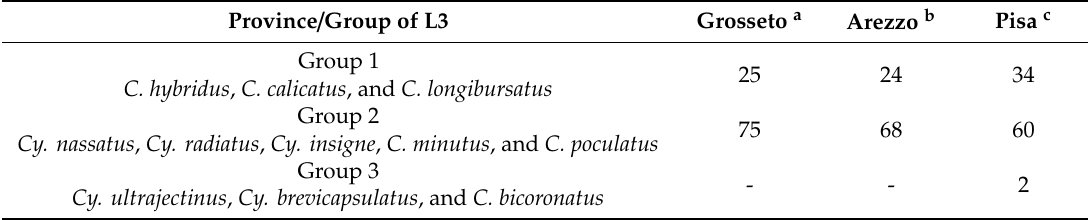
Table 1. Percentage (%) of small and large intestinal strongyle third stage larvae (L3) found in three different typologies of donkey farms in Tuscany, central Italy, identified according to Bevilaqua et al. [20].